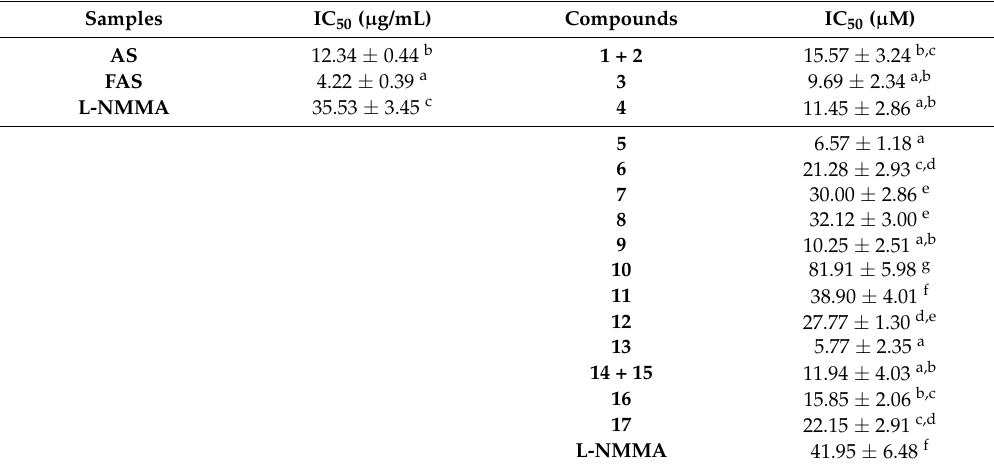
Table 3. IC50 values of compounds 1 – 17 for inhibition of nitric oxide